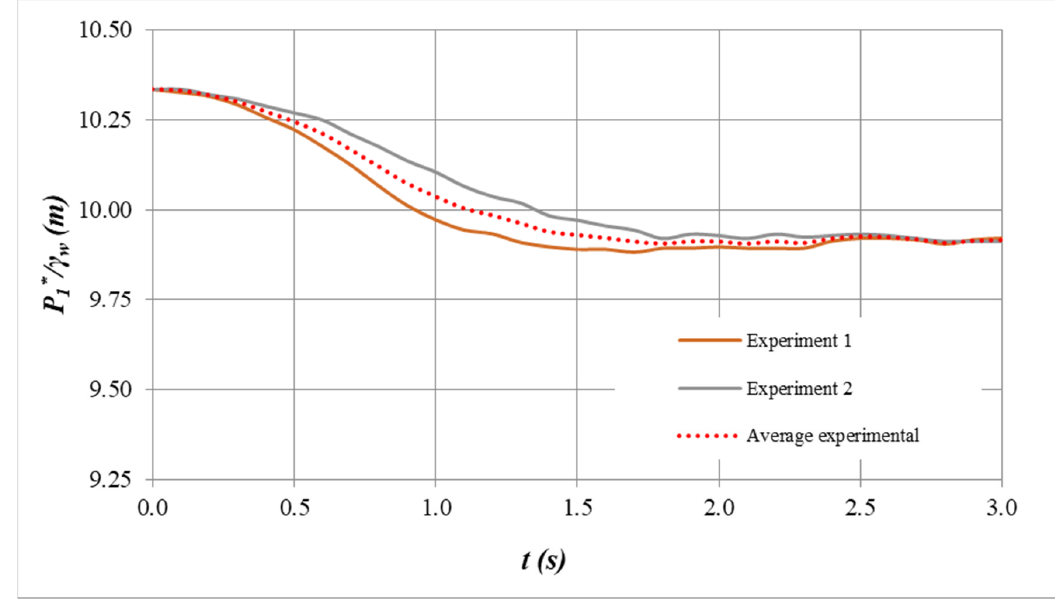
Figure 4. Experimental tests for case Table 3. Equations proposed by Navier-Stokes.